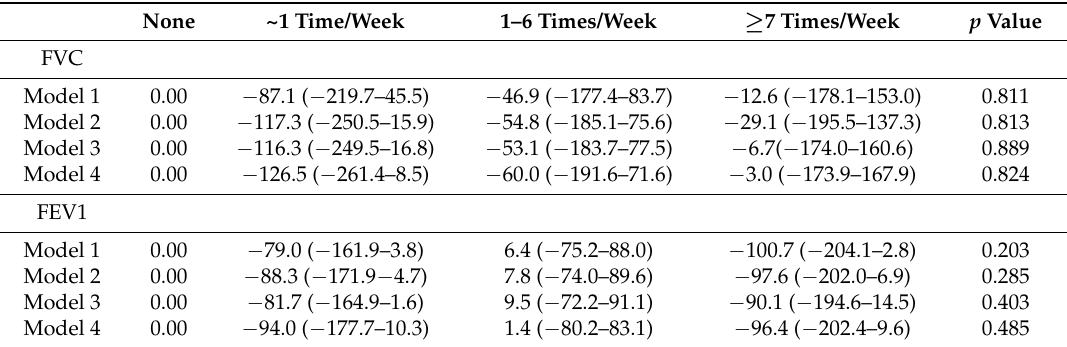
Table 3. Regression coefficients (95% CI) for FVC and FEV1 by soft drink consumption levels 1 .